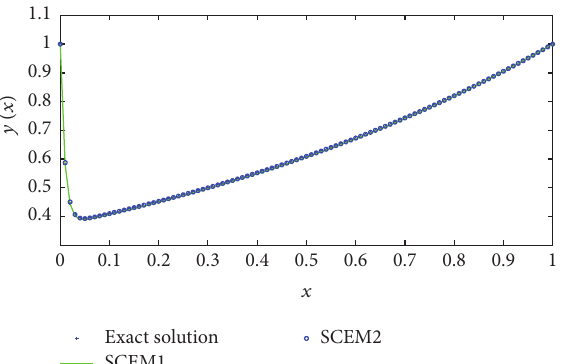
Figure 1: Left layer problem for 𝜀 = 0.01 and 𝛿 = 0.1𝜀 .